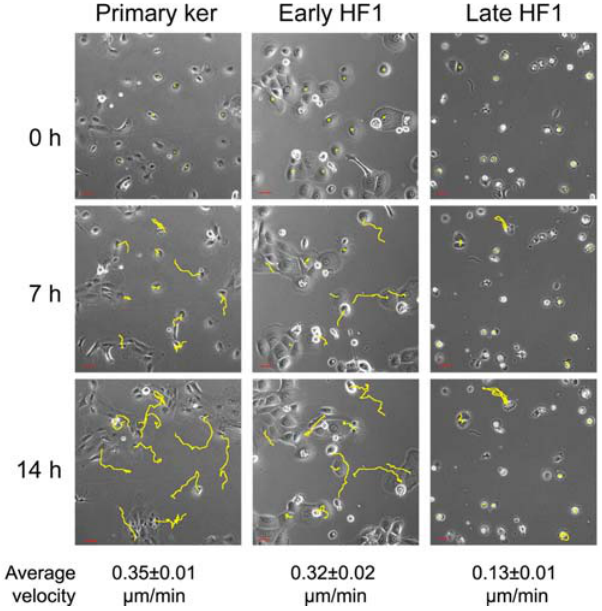
Figure 3. Individual cell motility in primary keratinocytes, early and late HF1 cells. Cell motility movies were created by acquiring live-cell images every 15 min throughout 14 h of the experiment. Cell tracks, in yellow, were determined by marking cell nuclei in every frame of the movie. The figure shows the same cells at the beginning of the experiment (0 h), after 7 h, and at the end of the movie (14 h). Cell velocity was calculated by marking the cell nucleus in every frame, and following cell movement. Average velocity was calculated by an application within the UCSF PRIISM environment ((http://msg.ucsf.edu/ ive). Errors represent standard error of . 100 cells examined in 3 independent experiments.